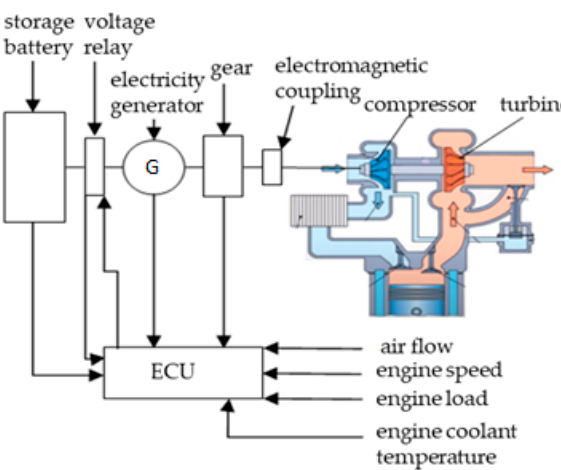
Figure 2. The structure of the hybrid turbocharger design [42].